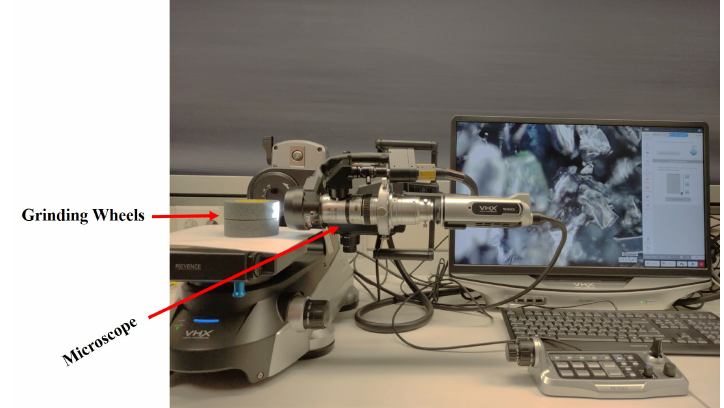
Figure 26. Grinding wheel topography detection platform.